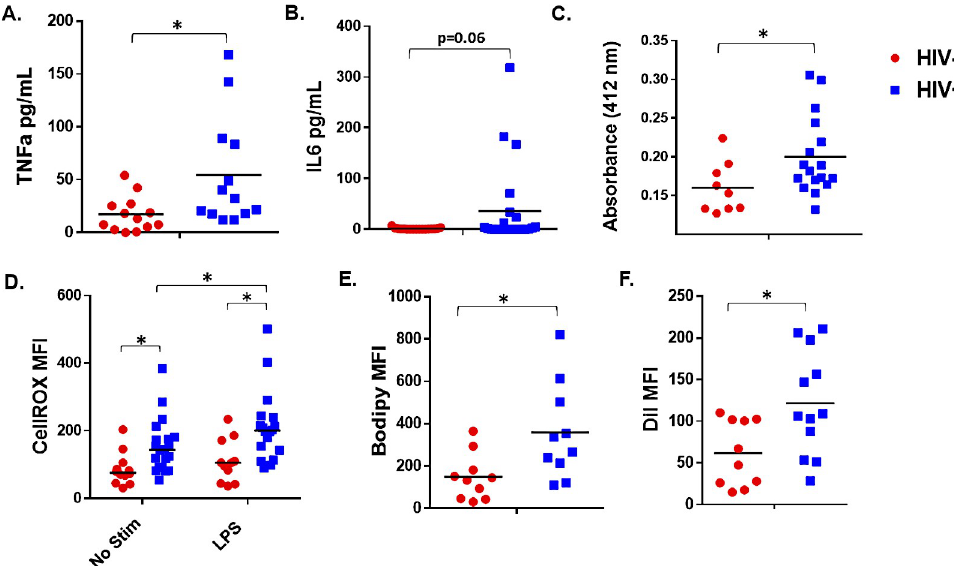
Fig 2. Altered macrophage function in PWH may contribute to vascular inflammation. Inflammatory cytokine production, A) TNF α and B) IL-6, was measured in MDM supernatants (24 h) by ELISA. C) Total MMP activity was measured in supernatants (24 h) from HIV- and HIV+ MDMs. Increased absorbance indicates greater MMP activity. D) MDMs were cultured in medium containing autologous serum alone (20%), or stimulated with LPS for 1.5 h (100 ng/ mL). Cells from HIV- and HIV+ donors were incubated with CellROX Deep Red, and intracellular production of ROS was measured by flow cytometry. E) Intracellular lipid accumulation was measured using Bodipy (493/503) stain and flow cytometry. F) Lipid uptake was measured by flow cytometry following exposure (4 h) of MDMs to labeled DiI-OxLDL. (p < 0.05).